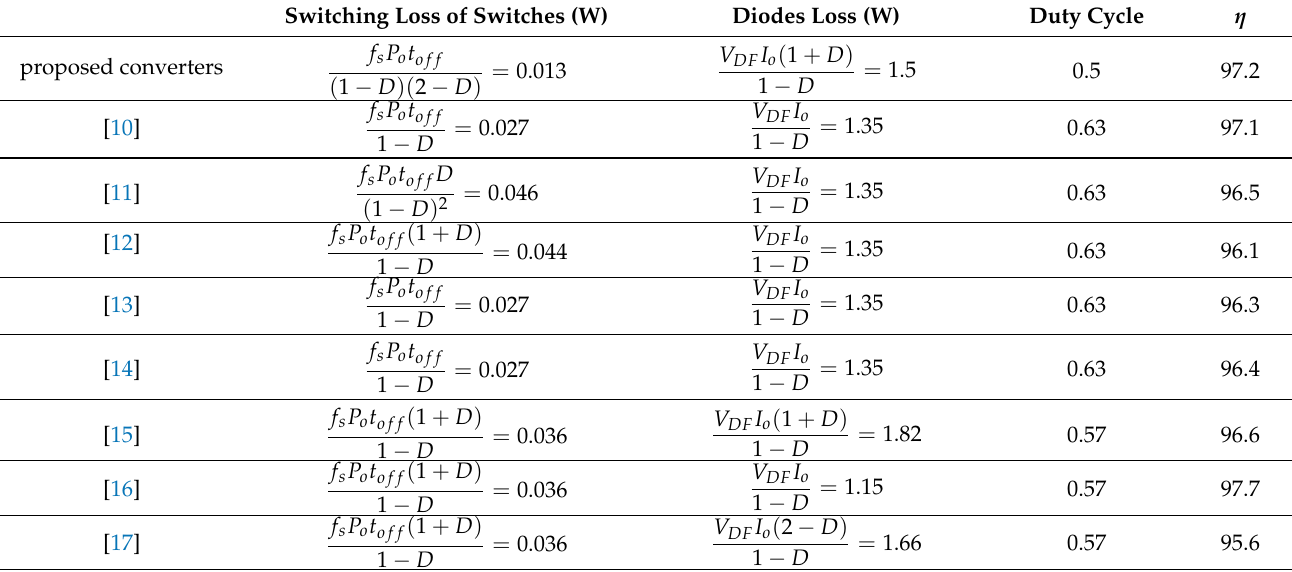
Table 2. Comparison of power loss in switches (switching) and diodes as the voltage gain ratio equals 3. Switching Loss of Switches (W) Diodes Loss (W) Duty Cycle η proposed